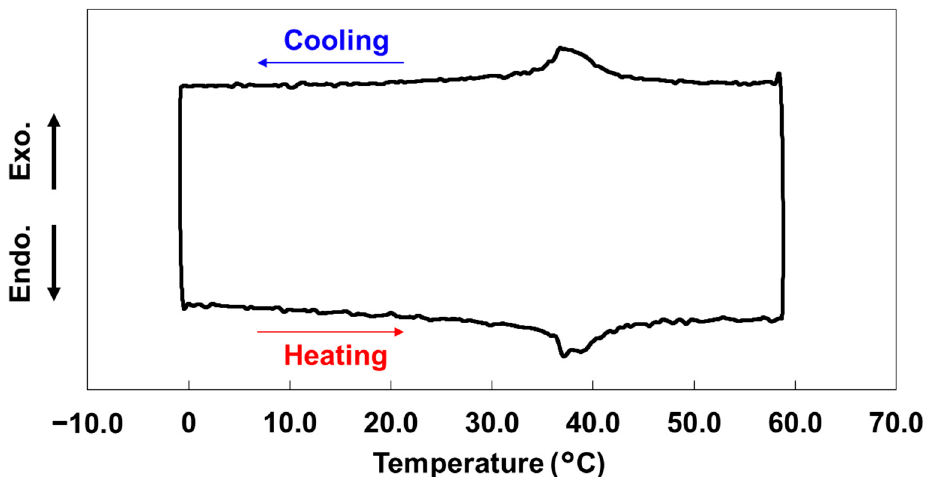
Figure 2. Differential scanning calorimetry (DSC) thermogram of the mixture at the third heating and cooling cycle. Scanning rate of 1 °C/min.